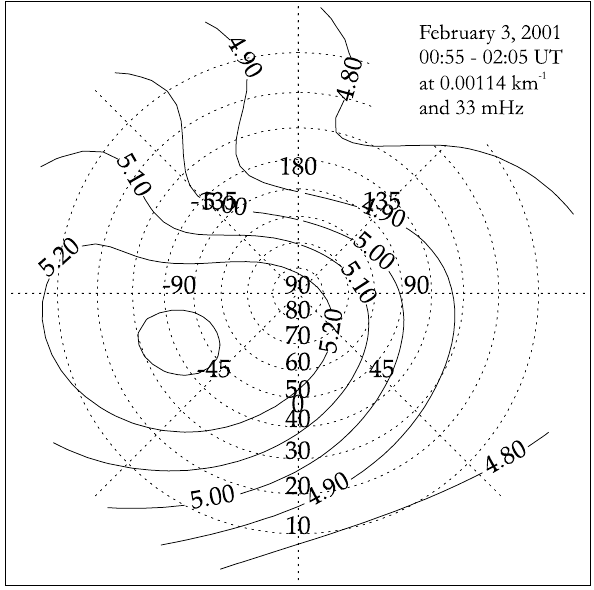
Fig. 11. Spectral density distribution on the k -shell k = 0 . 00115km − 1 resulting from applying the wave telescope to mea- surements in the solar wind during the interval on 3 February 2001, 00:55–02:05UT. The logarithm of the power, given in pT, is dis-